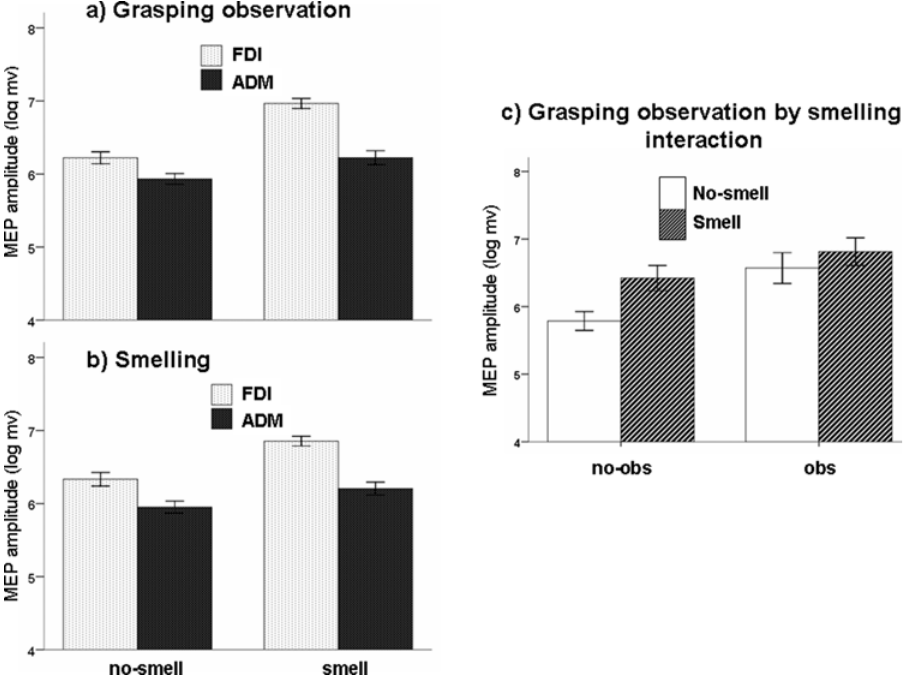
Figure 3. Results of Experiment 2 (only food objects). Graphical representations of the main significant interactions: a) an higher MEP increase occurred in FDI than in ADM when the subjects observed a grasping movement; b) similarly, an higher MEP increase occurred in FDI than in ADM when the subjects smelled a food; c) even if ‘‘smelling’’ produces a lower MEP increase with, than without, concomitant grasping observation, a significant further facilitation (27% in the original m V scale) was